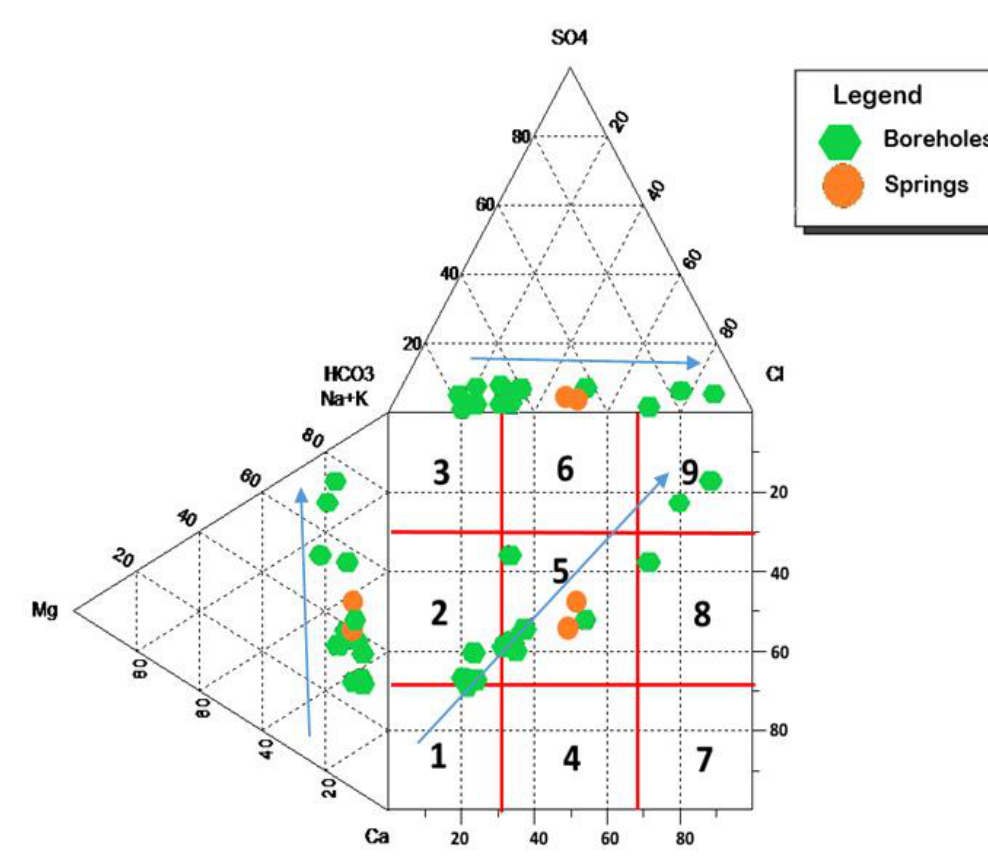
Figure 8. The Durov diagram for the Thyspunt water samples.